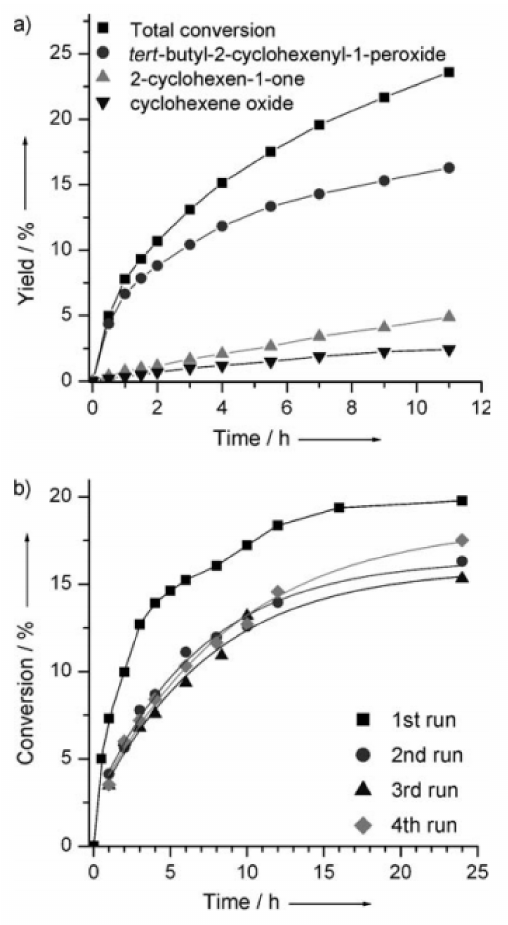
Figure 7. ( a ) Yield versus time curves for cyclohexene oxidation with MFU-1 as a catalyst. ( b ) Cyclo- hexene conversion versus time curves for catalytic oxidation using MFU-1 in four subsequent runs. Reproduced with permission from